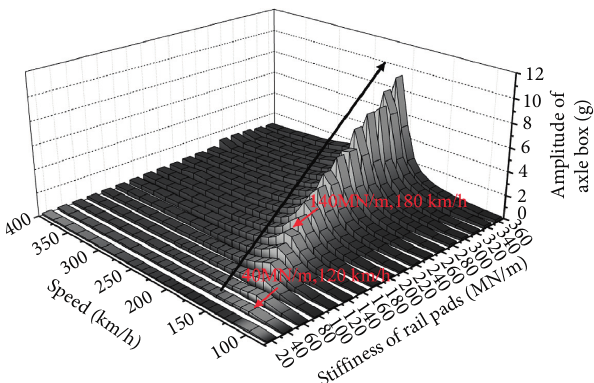
Figure 11: Maximum axle box accelerations due to sleeper passing impacts considering different vehicle speeds and vertical stiffness of rail pad.